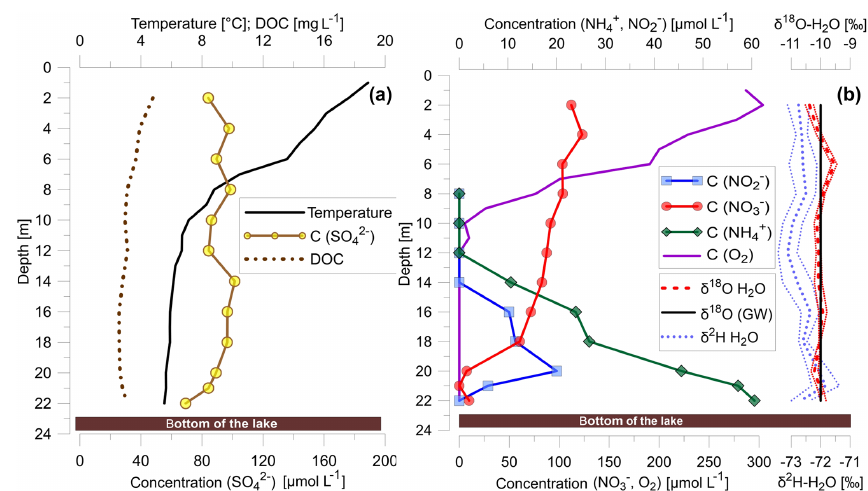
Figure 1. (a) Temperature profile and vertical distribution of concentrations of DOC and sulfate; (b) concentrations of dissolved nitrate, nitrite, ammonium and dissolved oxygen as well as δ 2 H and δ 18 O values of lake water and δ 18 O value of groundwater (GW).